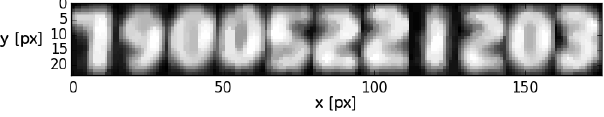
Figure 13. The extracted, scaled and normalised digits of image A (Fig. 4). The scaling is necessary for obtaining feature vectors of a constant size (384), and the intensity normalisation improves classification accuracy. Prediction: 79 005 22 12.